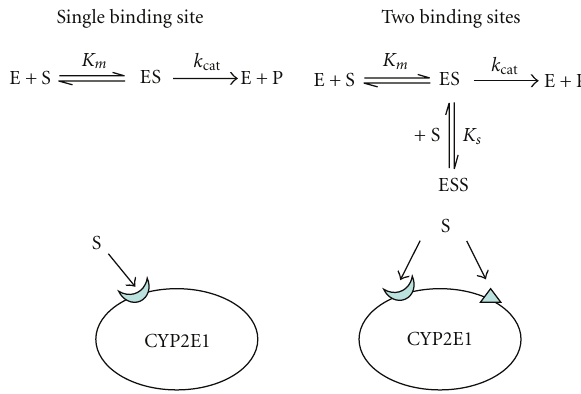
Figure 2: Comparison of single-sited and two-sited kinetics, adapted from